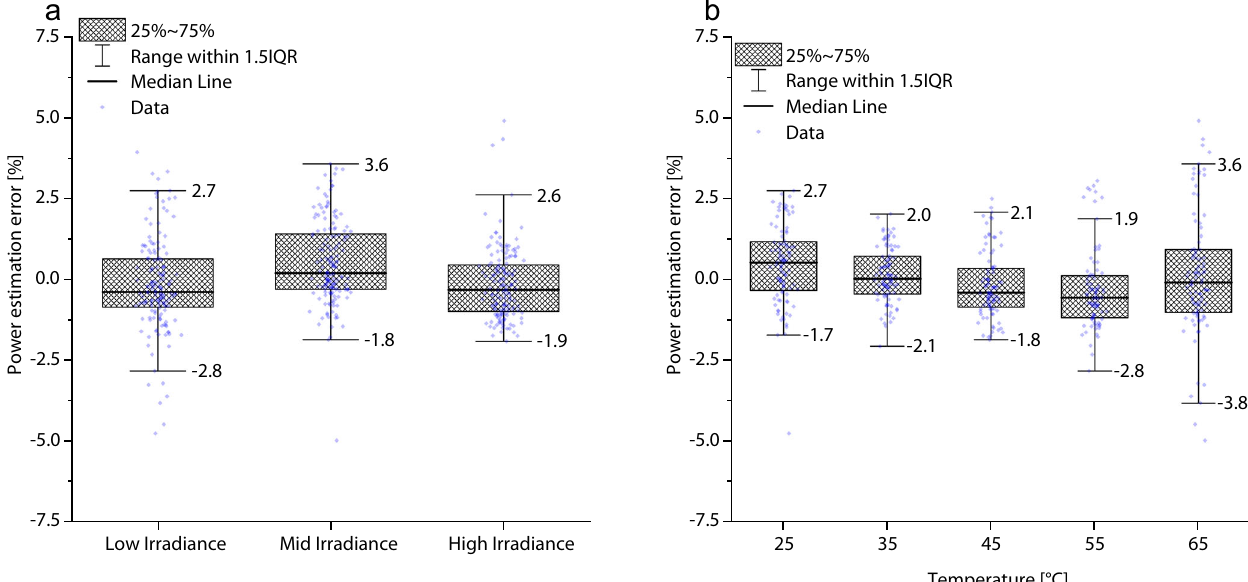
Fig. 7 Descriptive statistics of power estimation error. Statistical analysis of the model error across ( a ) different irradiance regions and ( b ) temperatures. ‘ Low Irradiance ’ , ‘ Mid Irradiance ’ and ‘ High Irradiance ’ represent the operating points within the ranges between 100 W m − 2 and 400 W m − 2 , 500 W m − 2 and 800 W m − 2 , and 900 W m − 2 and 1200 W m − 2 , respectively. The checked boxes show the middle 50% of the data points (i.e., the range between the 25th and 75th percentile). The whiskers represent data points outside the middle 50% and within 1.5 times the interquartile range (IQR).